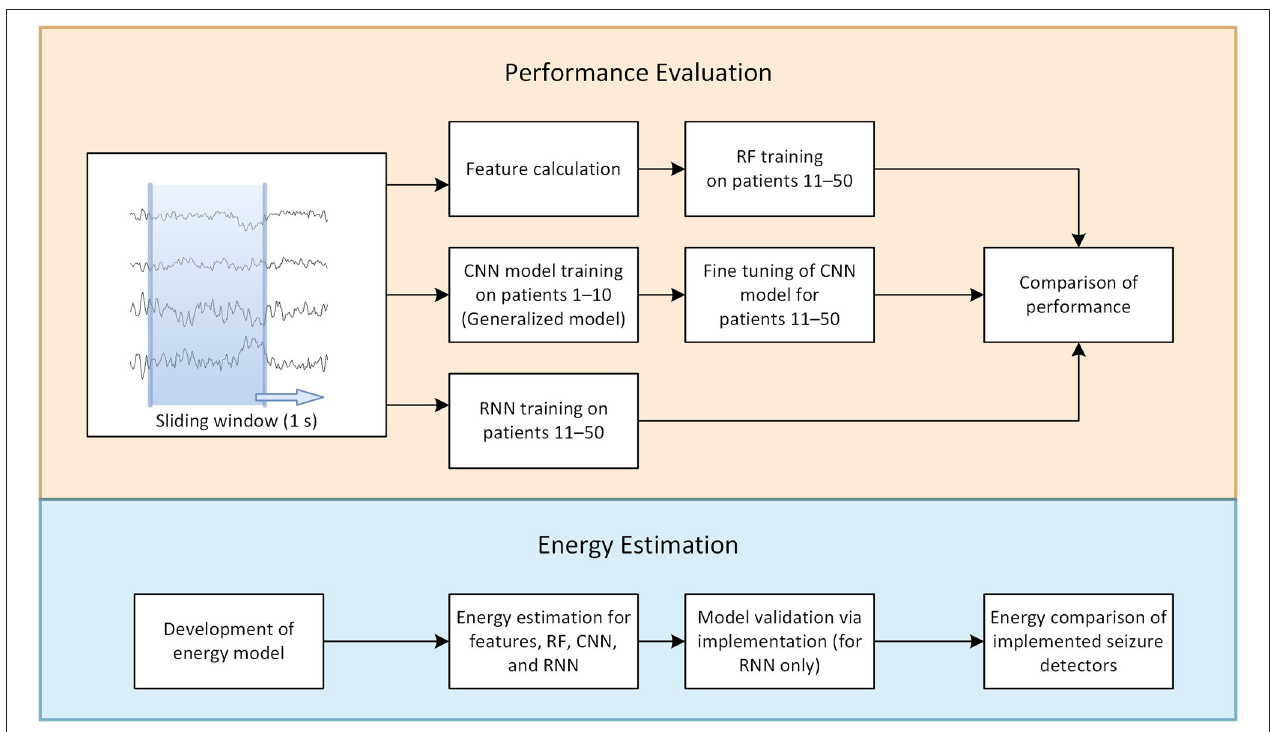
FIGURE 2 | Schematic outline of the study